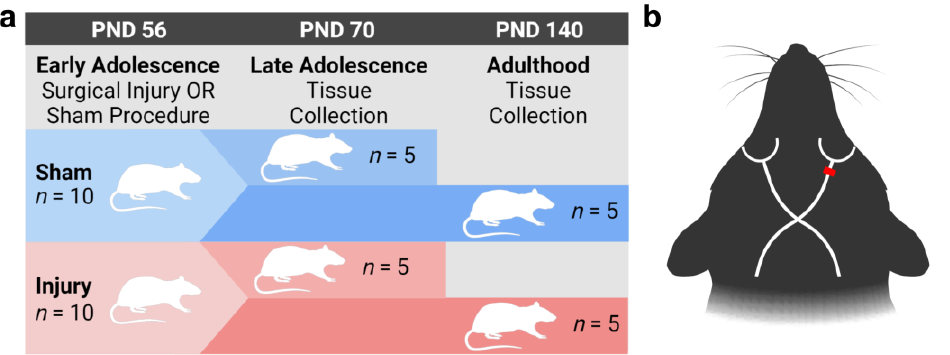
Figure 1. Experimental schematics. Experimental timeline of surgical injury via partial optic nerve transection, or sham procedure, on PND 56 (early adolescence) relative to tissue collection either 2 weeks later on PND 70 (late adolescence) or 3 months later on PND 140 (adulthood) ( a ). Schematic of rat head with superimposed optic nerve tracts. The red dash represents the location of partial optic nerve transection, or sham procedure, 1 mm behind the right eye ( b ).